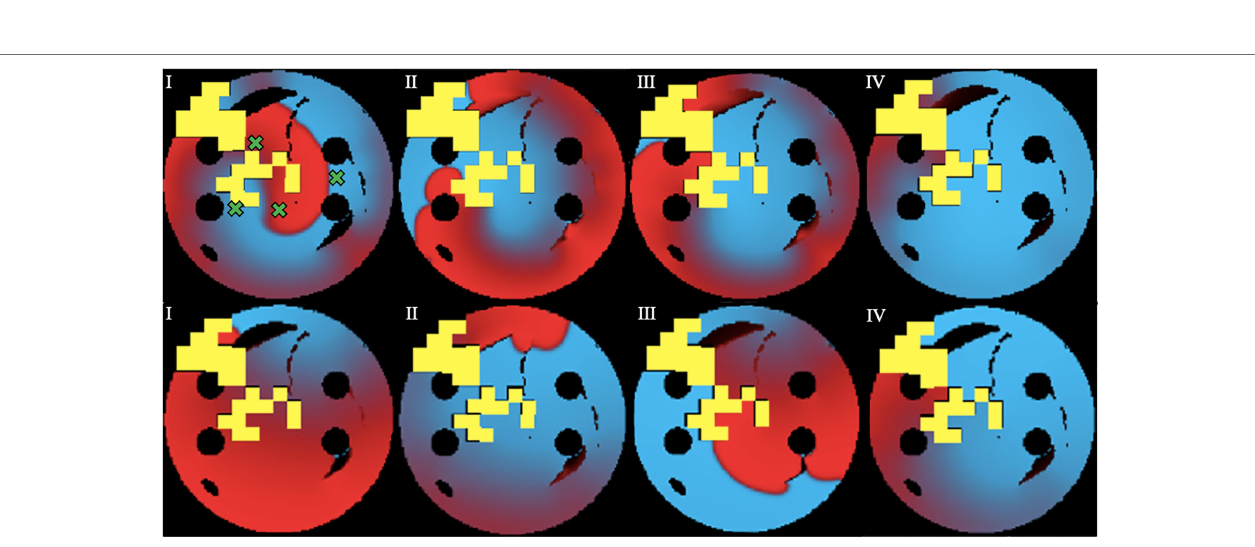
FIGURE 7 | Prevention of AF recurrence is shown using the successful ablation strategy identified by the agent during testing. This happens when rotor is re- initiated with both Scenario 1 (top row) and Scenario 2 (bottom row). Green crosses show the four locations of rotor initiation; the locations were chosen to produce most stable rotors pre-ablation. Voltage distributions in consecutive moments of time are shown in (I)–(IV)